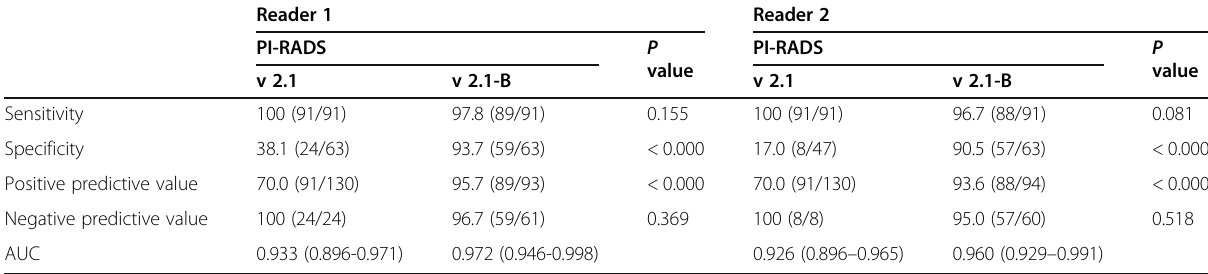
Table 4 Comparison of diagnostic performance for transition zone prostate cancer detection between PI-RADS v2.1 and PI-RADS